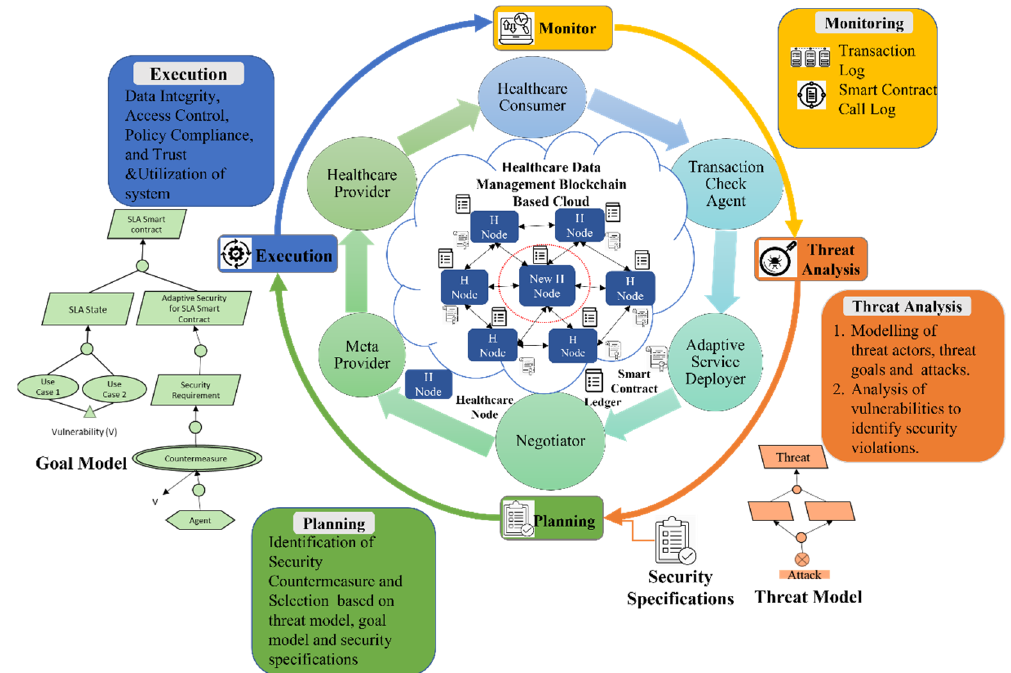
Figure 5. MAPE-BBC adaptation loop for SLA healthcare smart contract in BBC systems. SLA-Based Healthcare Data Management-Blockchain-Based Cloud (HDM-BBC) Smart Contracts